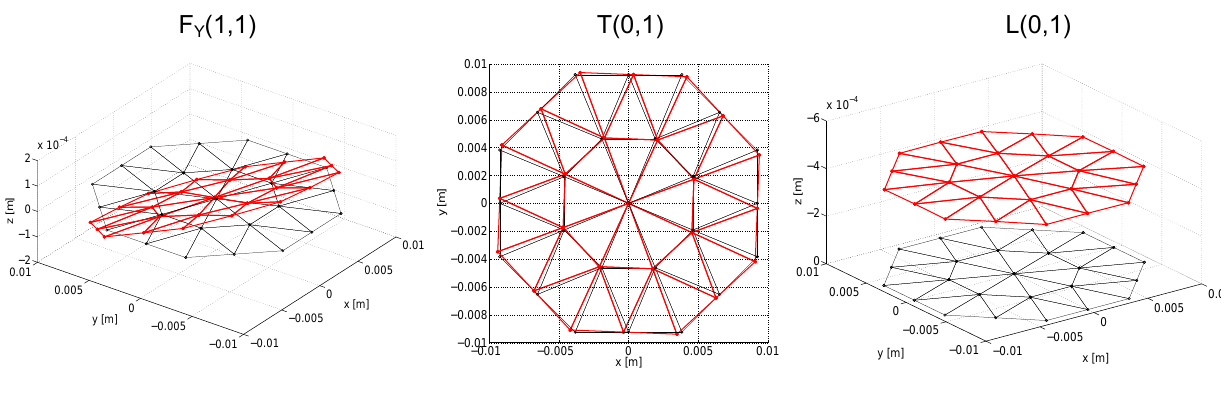
Figure 6 . Normalized wavestructures at around 30 kHz (32 CST triangles